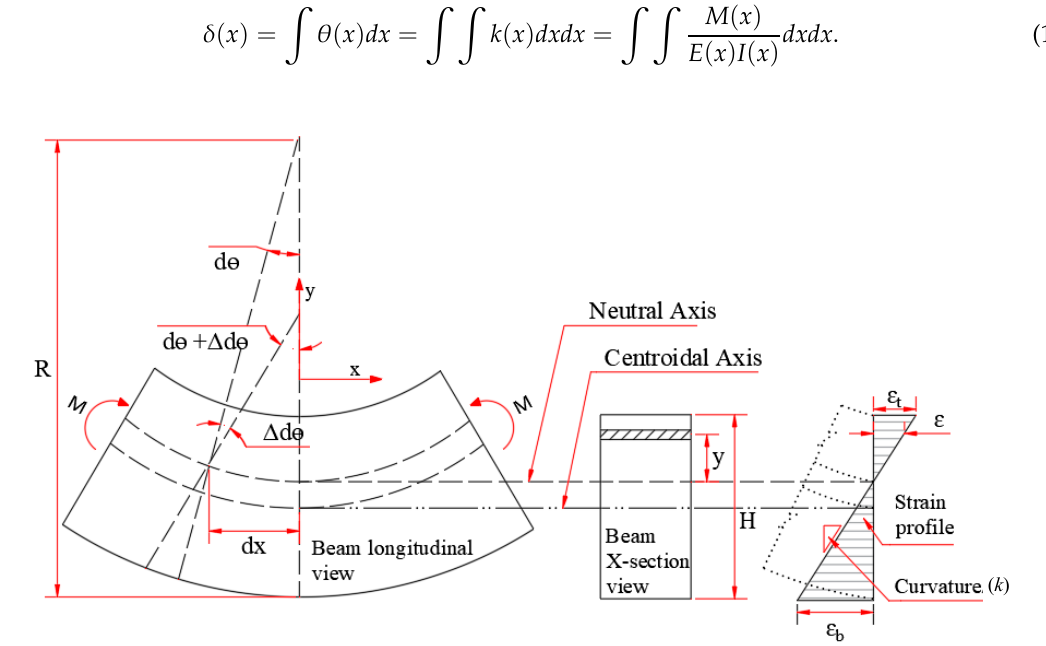
Figure 1. Curvature and strain profile of a beam.